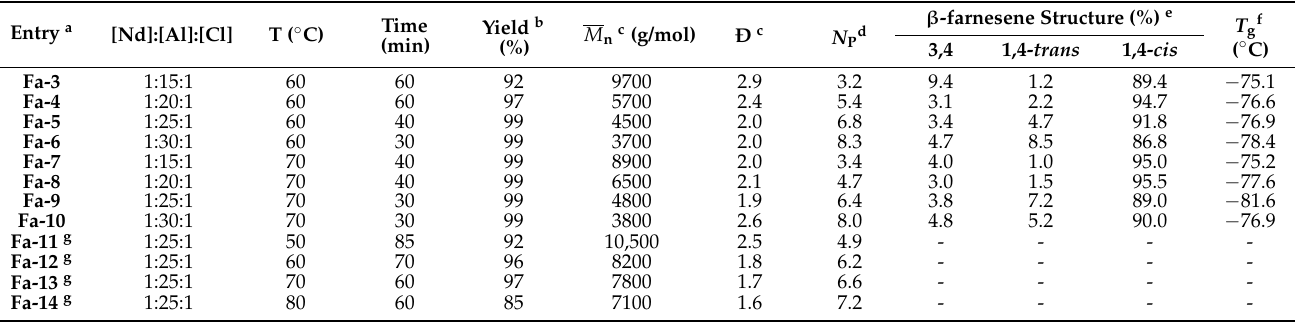
Table 4. β -farnesene polymerization initiated by NdV 3 /Al( i -Bu) 2 H/Me 2 SiCl 2 in cyclohexane at different reaction